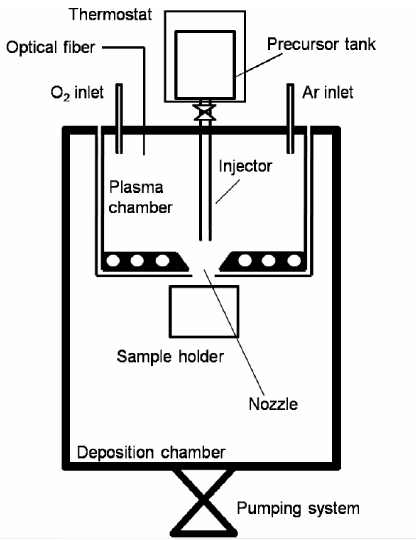
Figure 1. Schematic representation of the Plasma Assisted Supersonic Jet Deposition (PA-SJD) setup. The plasma chamber and the deposition chamber are connected by the converging